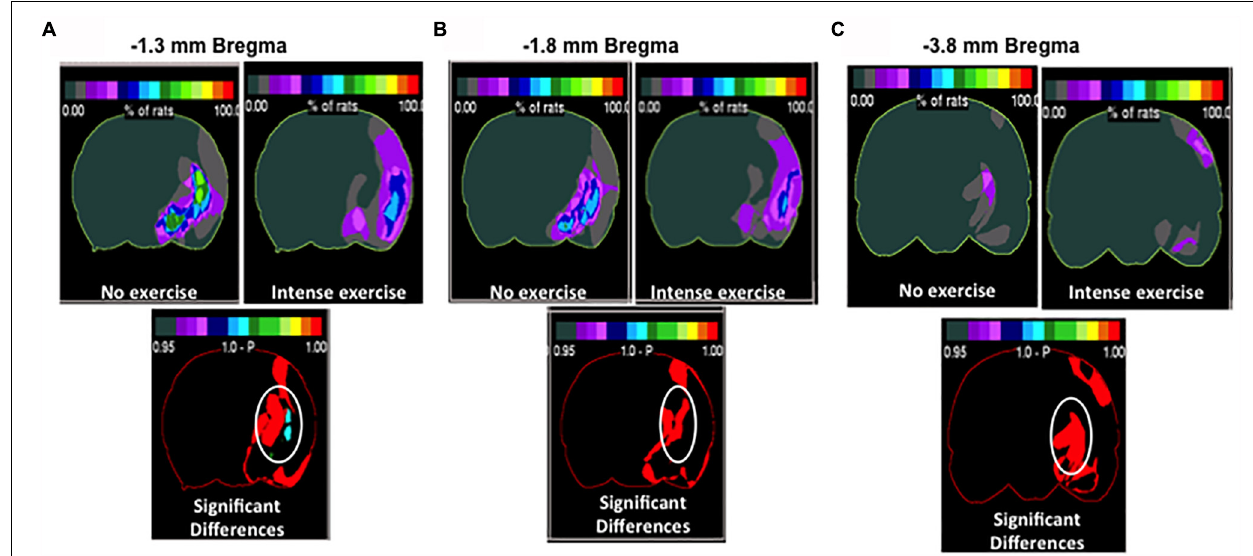
FIGURE 4 | Region specific infarct volume in aged male rats. Frequency heat map representation of infarct volume for each treatment group depicting location of region specific injury. Non-circled red is an increase in injury in the intense group. (A) Significant decrease in injury in the intense exercise group at –1.3 mm bregma was observed. There was an observed decrease in injury in the thalamus striatal injury and basal nucleus of Meynert. Non-circled red is an increase in injury in the intense group. (B) Highlighting –1.8 mm bregma showing a decrease in thalamic injury (C) –3.8 mm bregma showing a decrease in thalamic injury. Non-circled red is an increase in injury in the intense